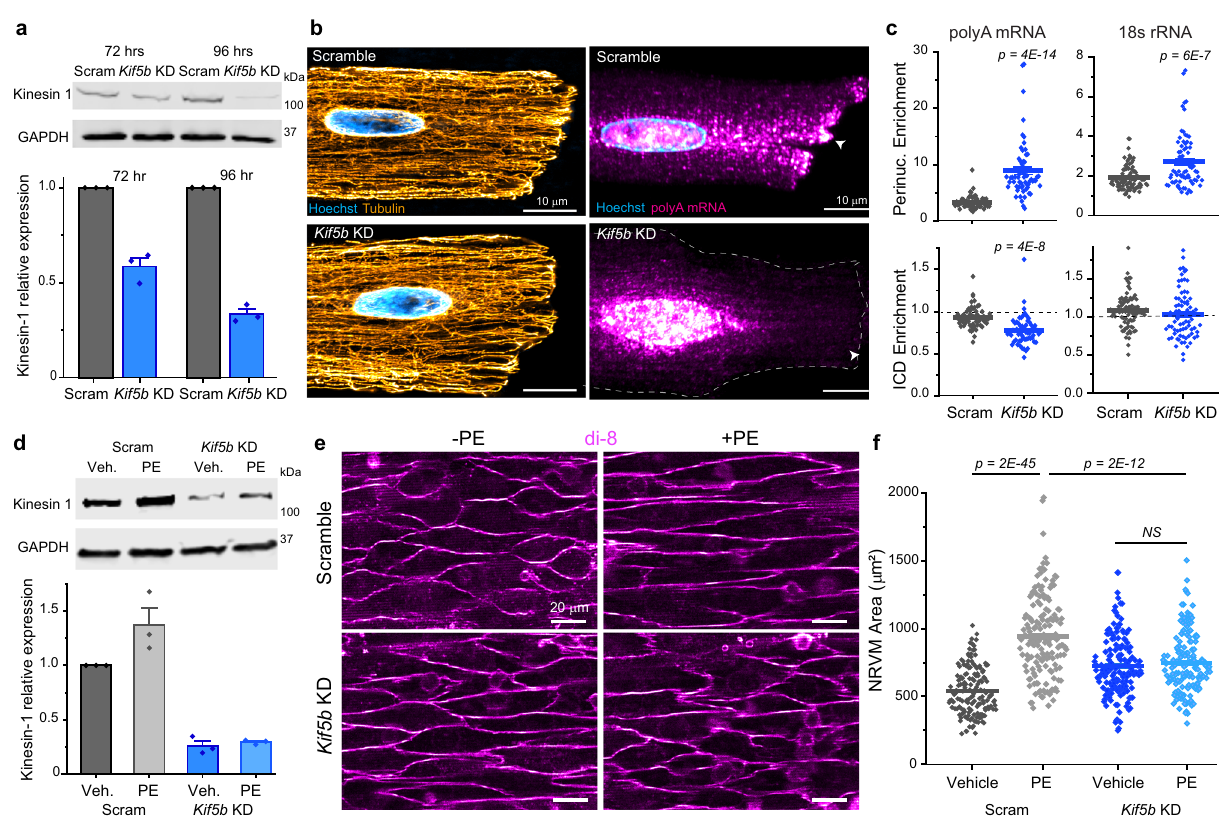
Fig. 6 mRNA localization and cardiac hypertrophy depends on the microtubule motor Kinesin-1. a (top) Representative western blot images of kinesin-1 and loading control GADPH in ARVMs. (bottom) Quanti fi cation of relative kinesin-1 expression, normalized to GAPDH. N = 3. b Representative immuno fl uorescence images of the microtubule network (left) and polyA mRNA (right) in Scramble and Kif5b KD cells. White arrow indicates ICD. c Nuclear:cytosolic and ICD:cytosolic ratios of polyA mean fl uorescence (left) and 18s rRNA mean fl uorescence (right) in Scramble and Kif5b KD cells. Scramble ( N = 2, n = 62, polyA) ( N = 2, n = 88, 18 s), Kif5b KD ( N = 2, n = 61, polyA) ( n = 2 , N = 76, 18 s). Statistical signi fi cance determined via two sample, two-tailed t -test. d (top) Representative western blot images of kinesin-1 and loading control GADPH in NRVMs. (bottom) Quanti fi cation of relative kinesin-1 expression, normalized to GAPDH. N = 3. e Representative live-cell images of (top row) Scramble or (bottom row) Kif5b KD NRVMS, treated with (left column) vehicle or (right column) PE. f Quanti fi cation of cell areas in NRVMs from experiment shown in e . Scramble + vehicle ( N = 3, n = 160), Scramble + PE ( N = 3, n = 160), Kif5b KD + vehicle ( N = 3, n = 160), Kif5b KD + PE ( N = 3, n = 160). For all graphs shown in fi gure, the mean line is shown, with whiskers denoting standard error (SE) from the mean. Source data are provided as a Source data fi spatiotemporal control of translation in cardiomyocytes. Our data indicate that translation location, and not simply a global increase